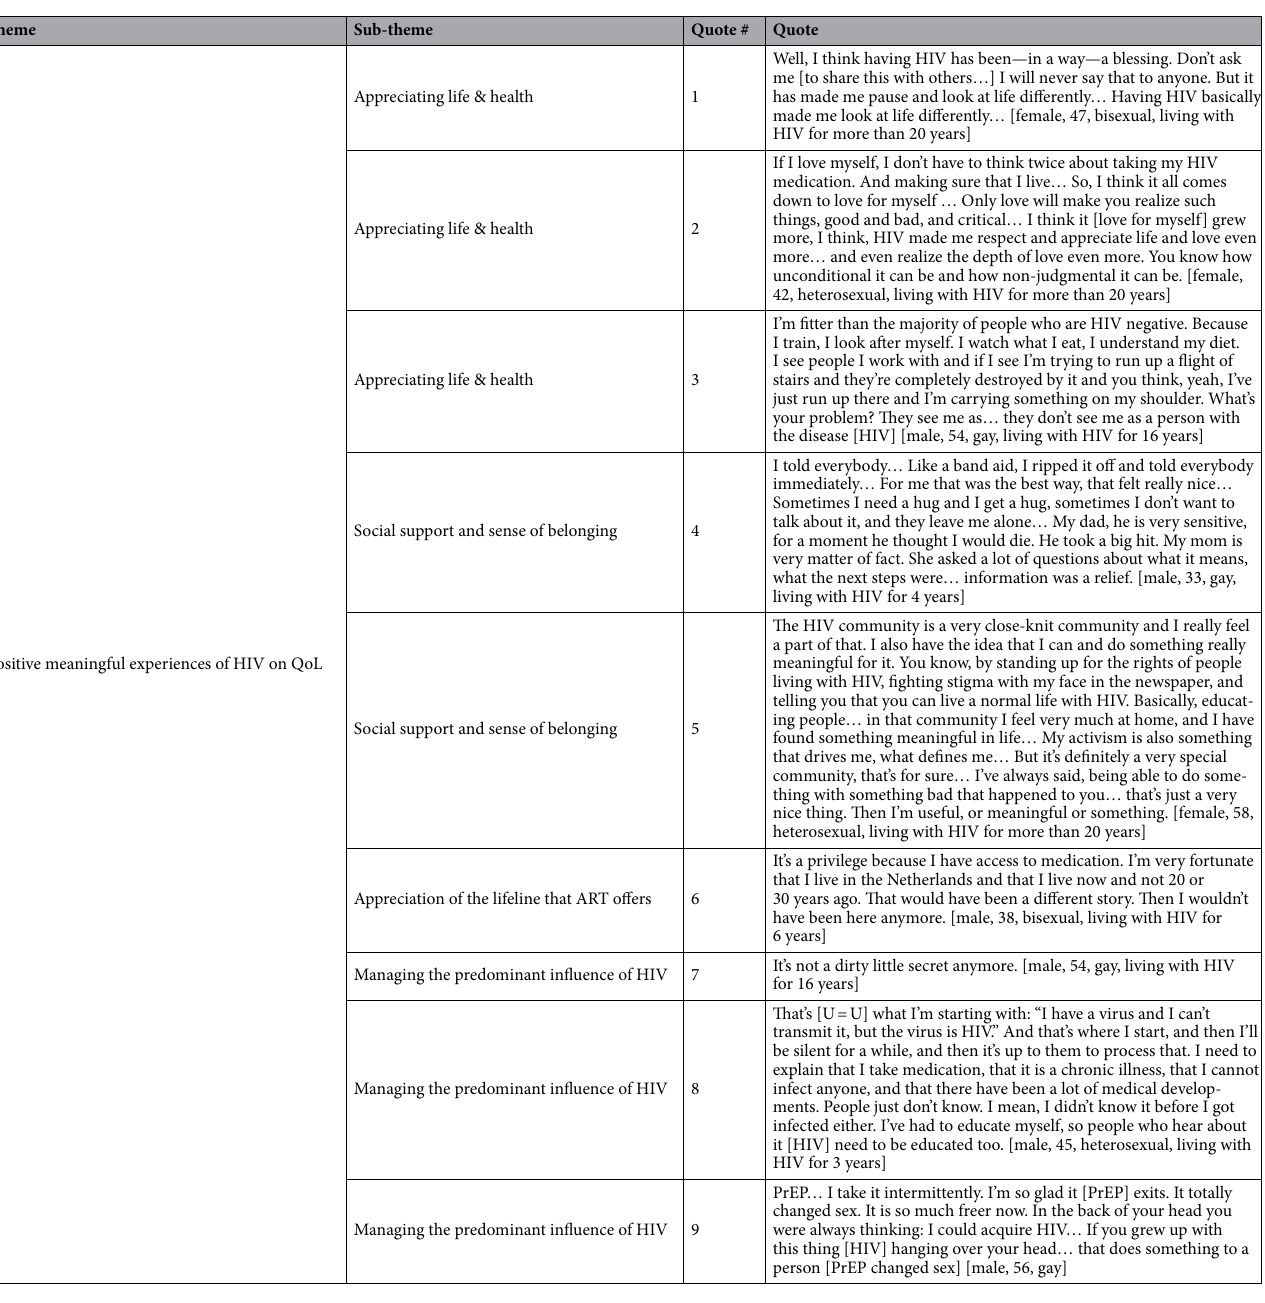
Table 2. Quotes supporting the positive meaningful experiences of HIV on